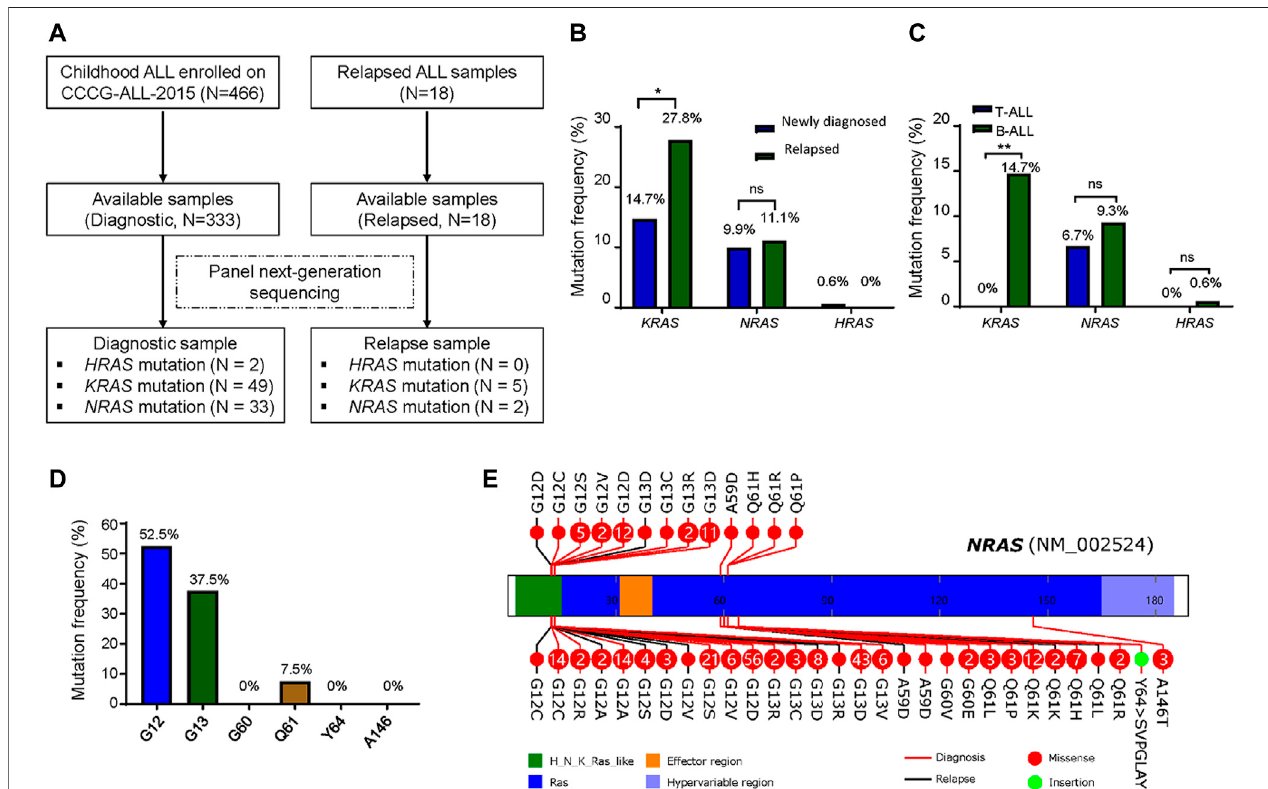
FIGURE 1 | RAS mutations in patients with newly diagnosed and relapsed ALL. (A) Identi fi cation of HRAS , KRAS and NRAS mutations in patients with newly diagnosed and relapsed ALL enrolled onto CCCG-ALL-2015 clinical trial at Guangzhou Women and Children ’ s Medical Center. (B) RAS mutations frequency between newly diagnosed ( N (cid:1) 333) and relapsed ( N (cid:1) 18) cases. (C) RAS mutations frequency between diagnostic T-ALL and B-ALL. (D) NRAS mutations frequency including G12, G13, G60, Q61, Y64 and A146 residues in this study cohort. (E) NRAS mutation pro fi le from our study cohort (upper panel) and PCGP study cohort. NRAS mutationsspannedthefulllengthofthegene(upperpanel,ourstudycohort;lowerpanel,PCGP;redline,newlydiagnosedALL;blackline,relapsedALL;solidredcircle, missense mutations; solid green circle, insertion mutations; number in this circle represents case number). McNemar chi-square test was performed to compare the frequency of KRAS , NRAS , and HRAS . p < 0.05 (*, < 0.05; **, < 0.01) was considered statistically signi fi cant.